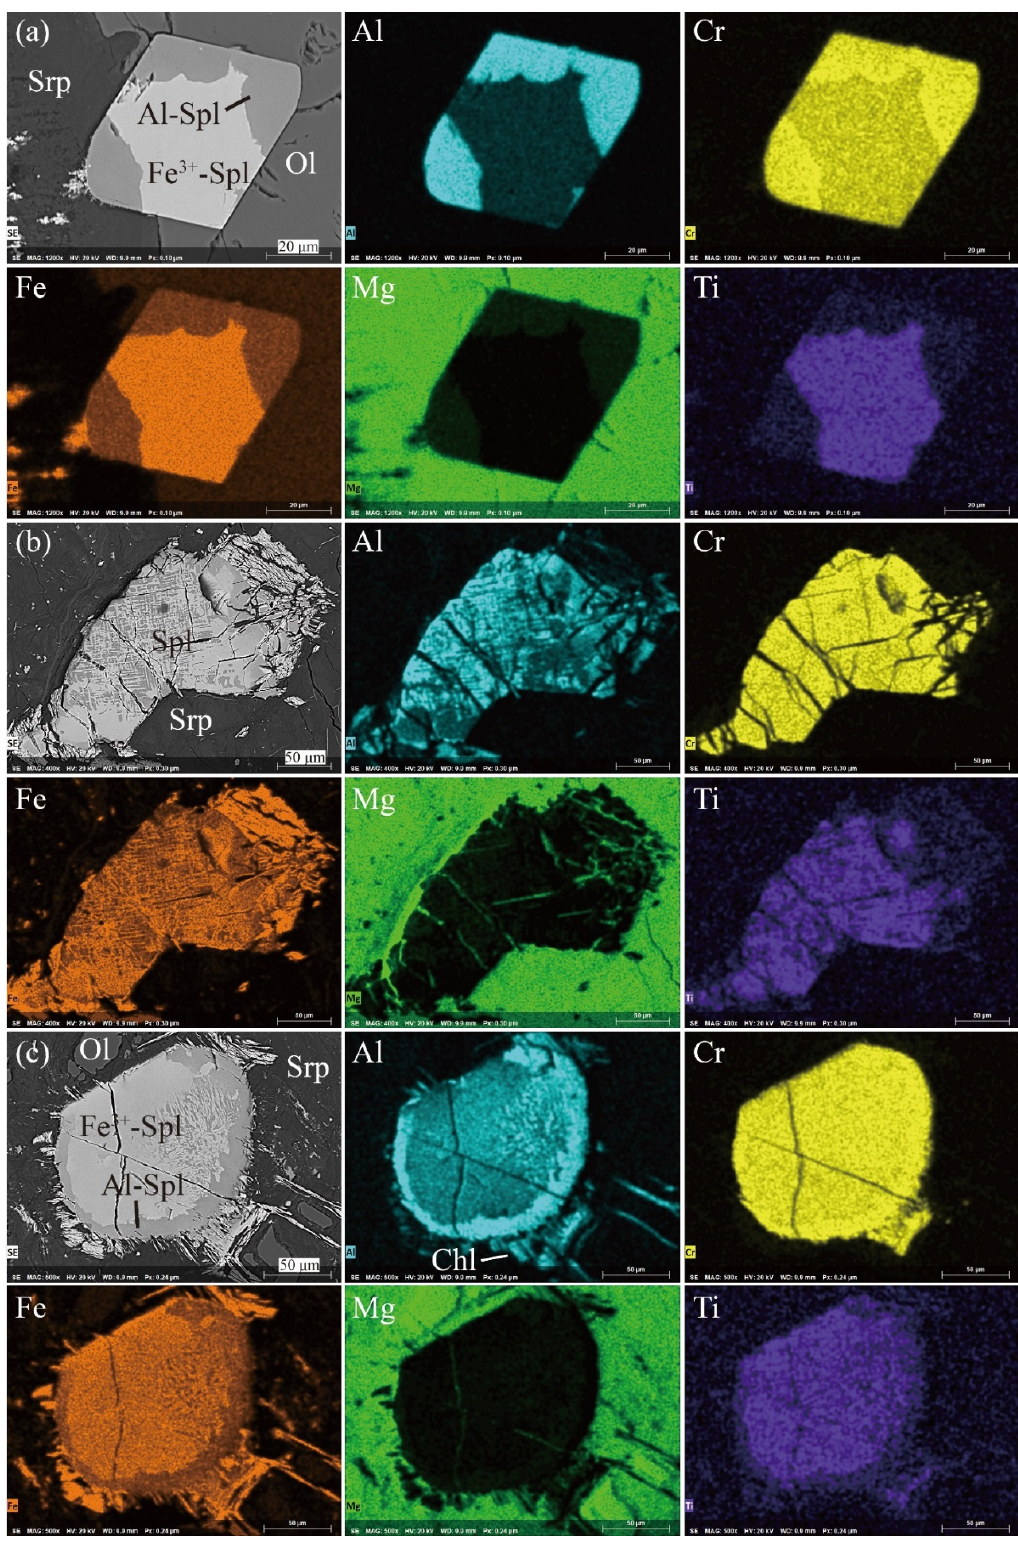
Figure 6. BSE images and multi-element mapping images of type B spinel in dunite. ( a ) Euhedral type B 1 Cr-spinel , ( b ) anhedral type B 2 Cr-spinel , ( c ) subhedral type B 3 Cr-spinel . Type B spinel grains ranges from anhedral to euhedral in shape and are inhomogeneous in chemistry, which basically consist of two parts: Fe 3+ -rich spinel, and Al-rich spinel. Chl, chlorite.